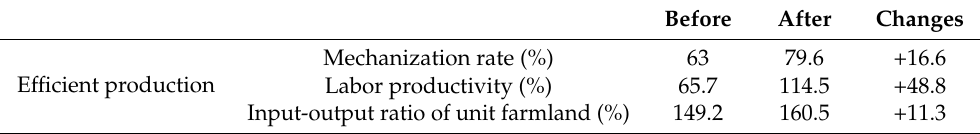
Before After Changes